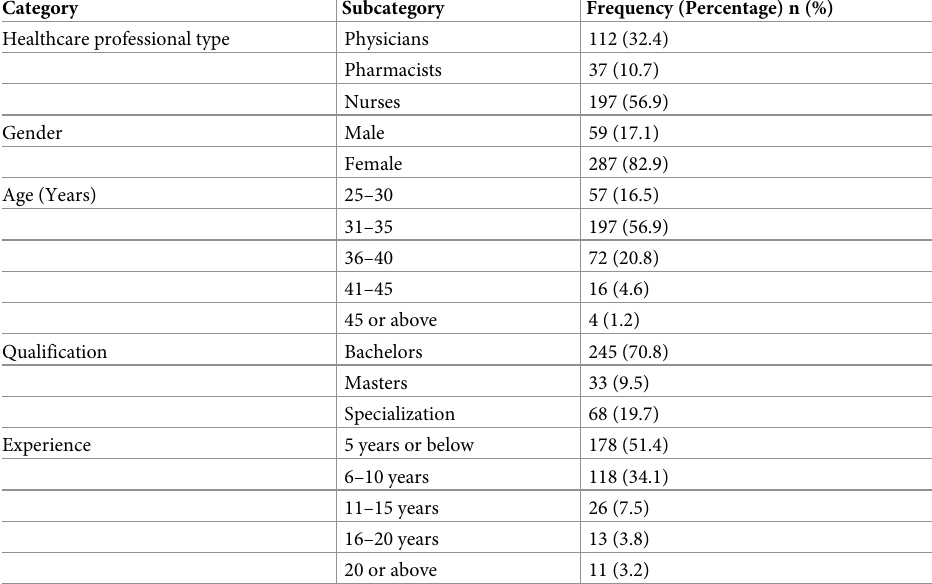
Table 1. Demographics of the participants (n =